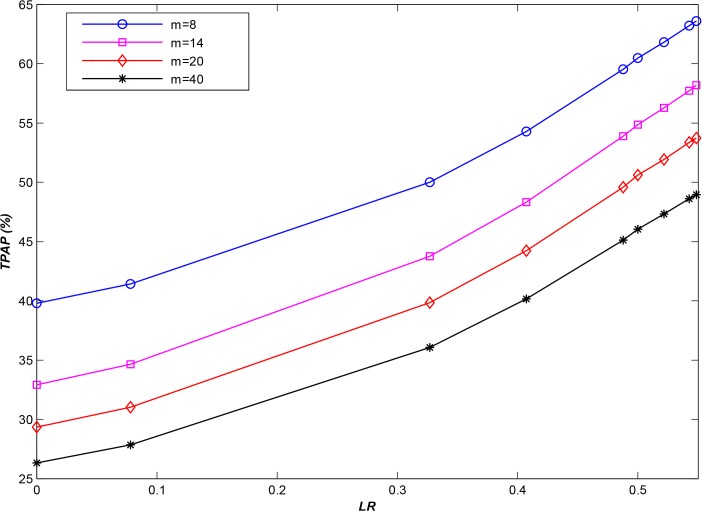
The performance improvement at various LRs (N = 20,000).